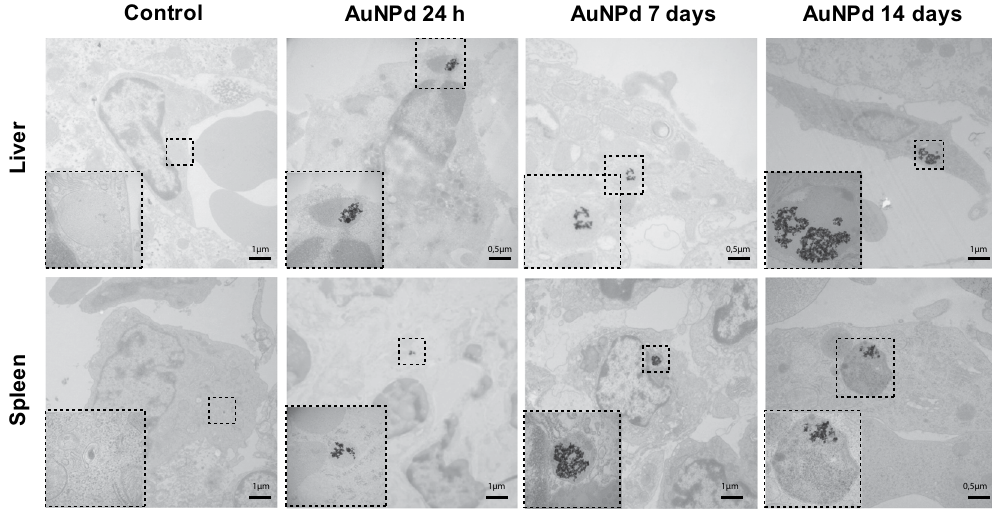
Figure 6. Representative TEM micrographs of Kupffer cells in liver and macrophages in spleen of mice 24 h, 7 and 14 days after intravenous injection of AuNPd (1 mg/kg) compared to the control group administered with vehicle alone. Magnified views of the square area show endolysosomal compartment containing clustered AuNPd in treated animals.